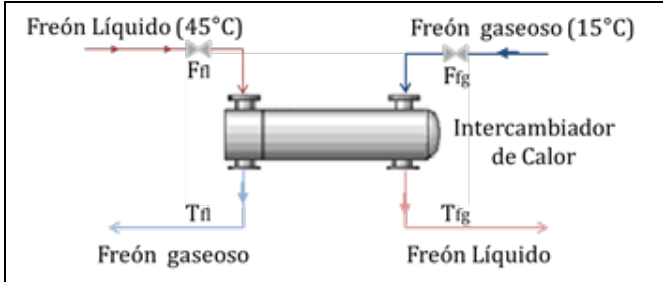
Figura 4: Intercambiador de Calor freón líquido- freón gaseoso da la planta objeto de